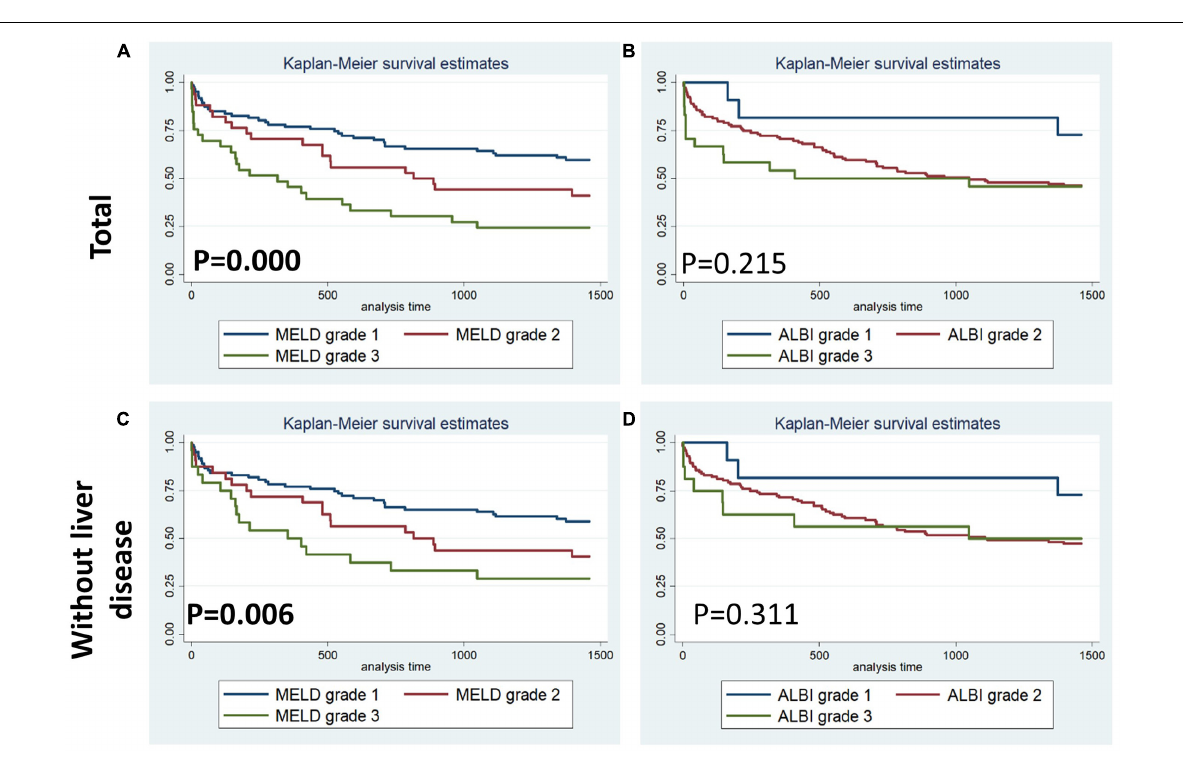
mortality: OR = 1.00, 95% CI = 1.00–1.01, p = 0.049; for AST, hospital mortality: OR = 1.00, 95% CI = 1.00–1.01, p = 0.008, 90-day mortality: OR = 1.00, 95% CI = 1.00–1.01, p = 0.022). In the total PPH group, total bilirubin was correlated with hospital mortality (OR = 1.08, 95% CI = 1.00–1.16, p = 0.048). MELD score was correlated with hospital mortality (total: OR = 1.12, 95% CI = 1.06–1.18, p < 0.001), 90-day mortality